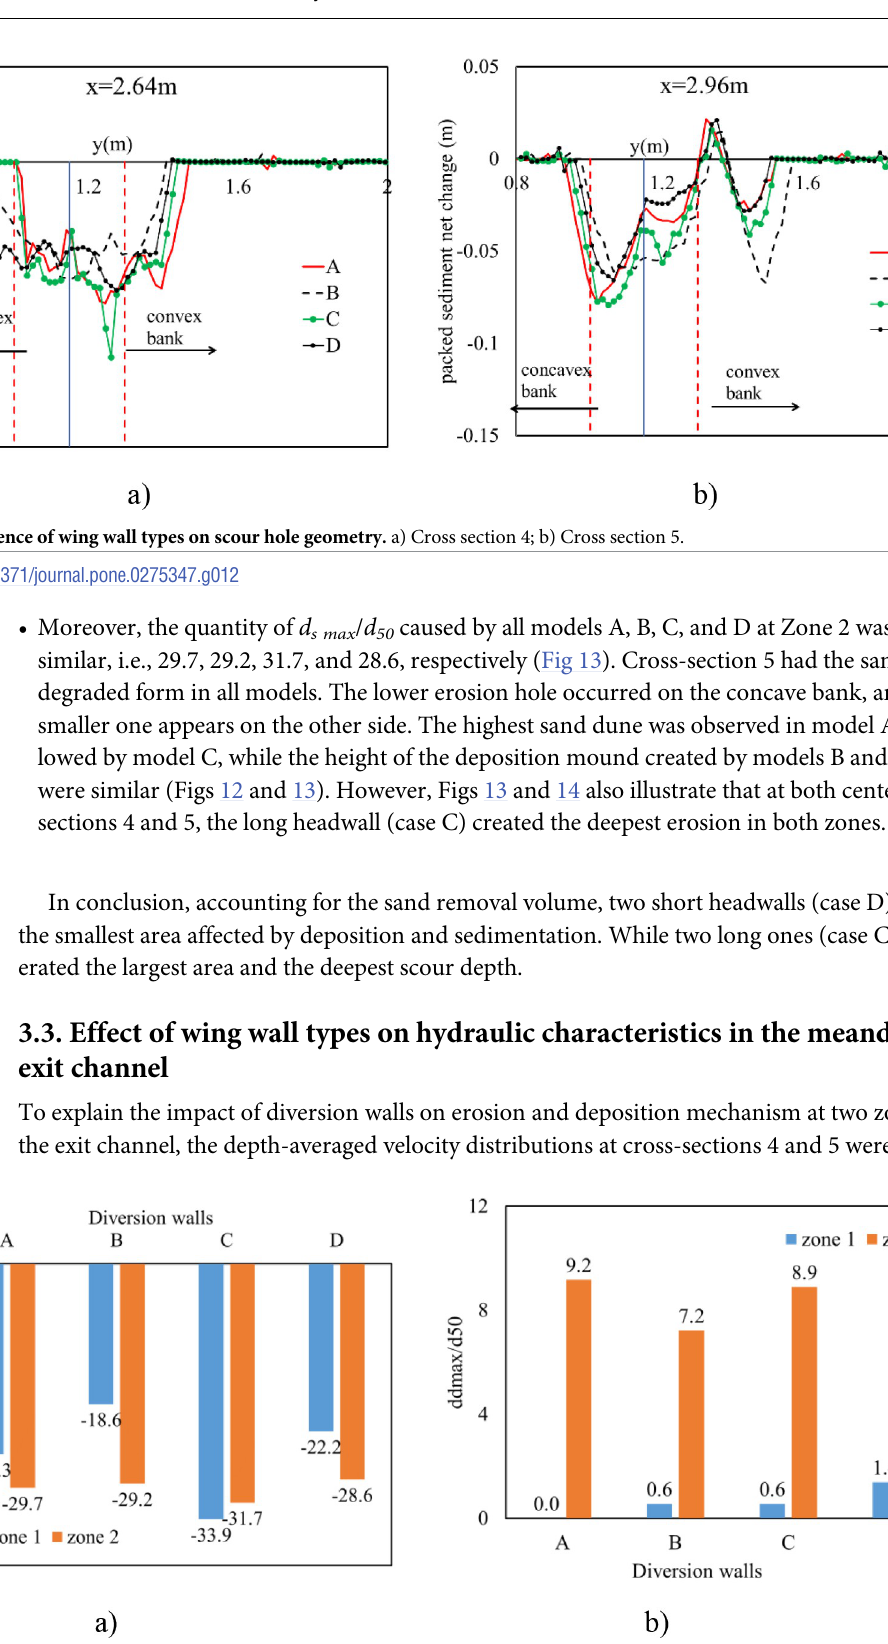
Fig 13. Maximum scour depth and height deposition after culvert and meander segment. a) Erosion hole; b) Deposition ridge.